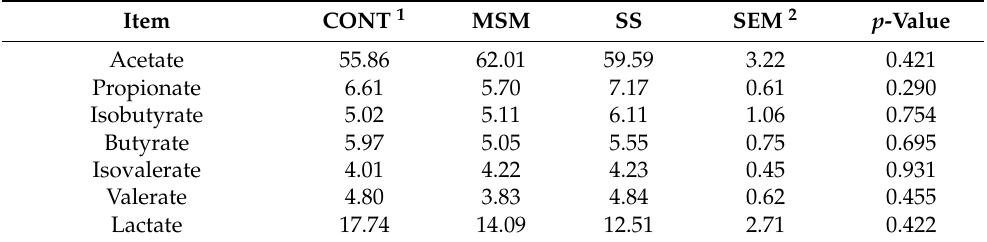
Table 7. Effects of dietary sulfur on the percentages (%) of ileal short-chain fatty acids in laying hens ( n = 8).